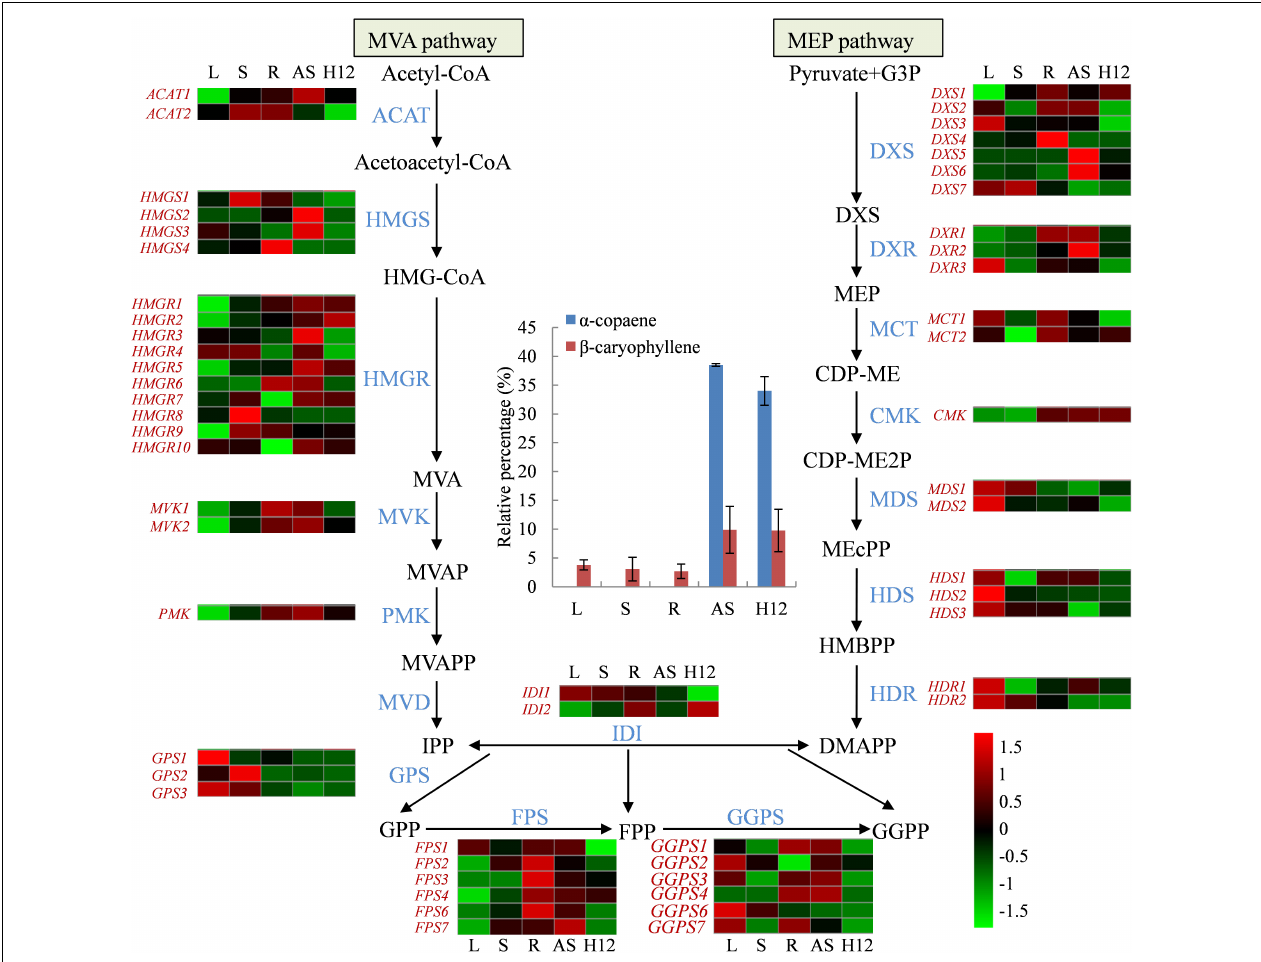
FIGURE 3 | The terpene backbone biosynthesis pathway in S. glabra . The terpene backbone biosynthesis is catalyzed by seventeen enzymatic steps with multiple isozymes in each step. The expression levels of genes are presented with the heat map. The bars in the center area exhibit the α -copaene and β -caryophyllene content in five various tissues. L, leaf; S, stem from young plants; R, root; AS, stem from adult plants; H12, stem from high oil-yielding plant. ACAT, acetyl-CoA acetyltransferase; HMGS, hydroxymethylglutaryl -CoA synthase; HMGR, hydroxymethylglutaryl-CoA reductase; MVK, mevalonate kinase; PMK, phosphomevalonate kinase; MVD, mevalonate diphosphate decarboxylase; DXS, 1-deoxy-xylulose 5-phosphate synthase; DXR,1-deoxy- D -xylulose-5-phosphate reductoisomerase; MCT, 2-C-methyl- erythritol 4-phosphate cytidylyltransferase; CMK, 4-(cytidine 5 (cid:48) -diphospho) -2-C-methyl- D -erythritol kinase; MDS, 2- C -methyl- D -erythritol 2,4-cyclodiphosphate synthase; HDS, (E)-4-hydroxy-3-methylbut-2-enyl-diphosphate synthase; HDR, 4-hydroxy-3-methylbut-2-enyl diphosphate reductase; IDI, isopentenyl di-phosphate isomerase; GPS, Geranyl diphosphate synthase; FDPS, farnesyl pyrophosphate synthase; GGPS, geranylgeranyl diphosphate